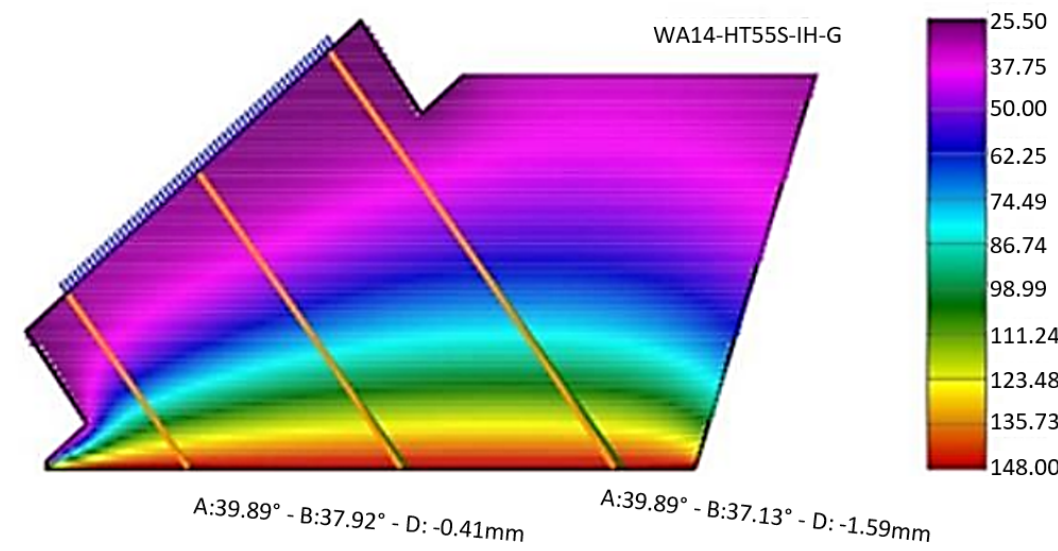
Figure 4. Beam variation with temperature.